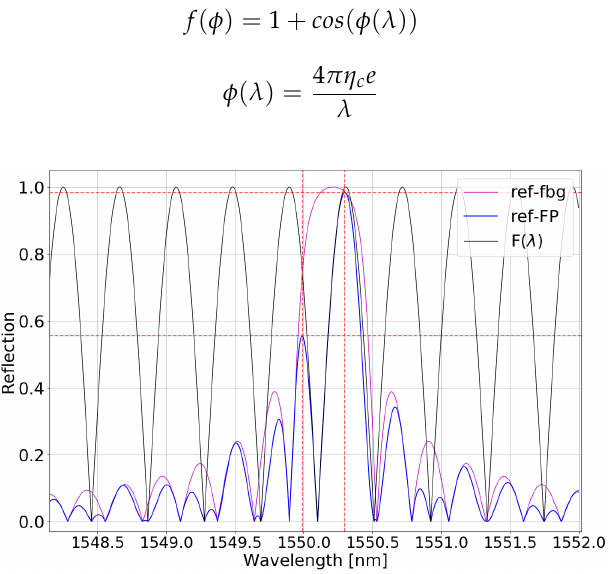
Figure 2. Normalized reflection spectrum of the FP